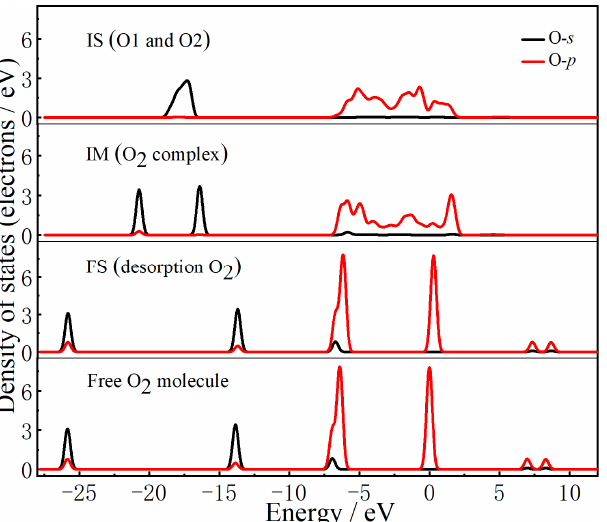
Figure 3. The DOS for O atoms (O1, O2), O 2 complex, and free O 2 molecule in the path 1 process. Next, the oxygen release reaction on the CuO(111) surface was simulated. Of particular note, the oxygen release reaction on the CuO(111) surface was studied by the work of Zhang et al. [44]. However, the calculation methods were slightly different from those in this paper. In order to make the results in this work as comparable as possible, the O 2 formation and desorption processes were still calculated here, and the results are shown in Figures 4 and 5. There are two pathways for oxygen release on the CuO(111) surface, which are denoted as path 1 (P1) and path 2 (P2). The details of model construction are not repeated here. The energy barriers of O 2 formation in path 1 and path 2 are 3.18 eV and 2.47 eV, respectively. Both O 2 desorption processes are largely endothermic by 3.61